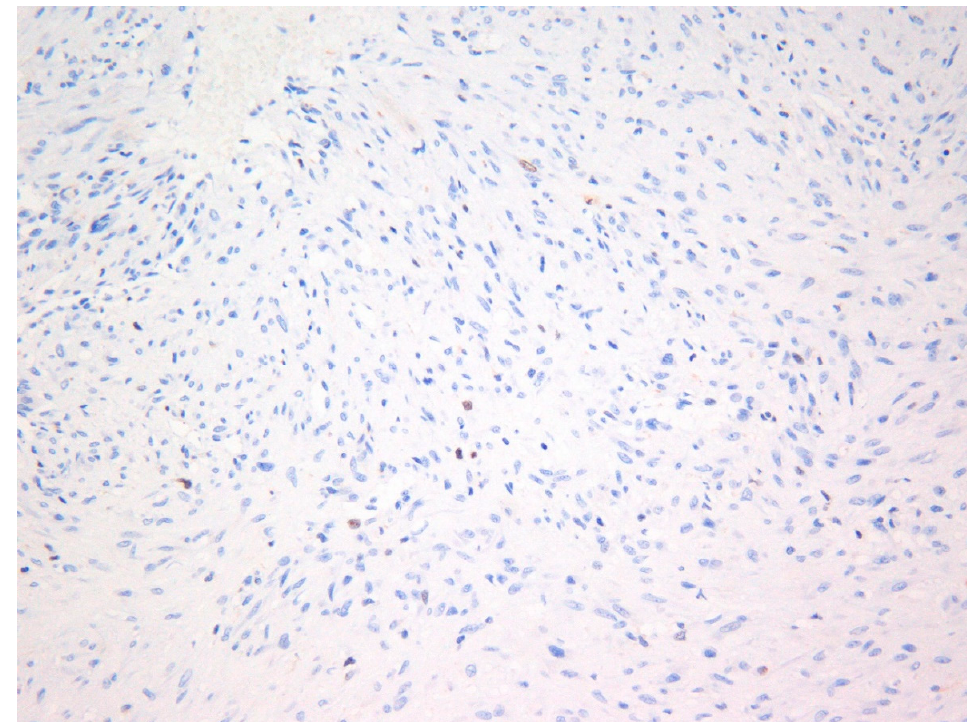
Figure 2. Photomicrograph showing Ki-67 (MIB-1) positivity in tumor cells—Case 1 (×40).